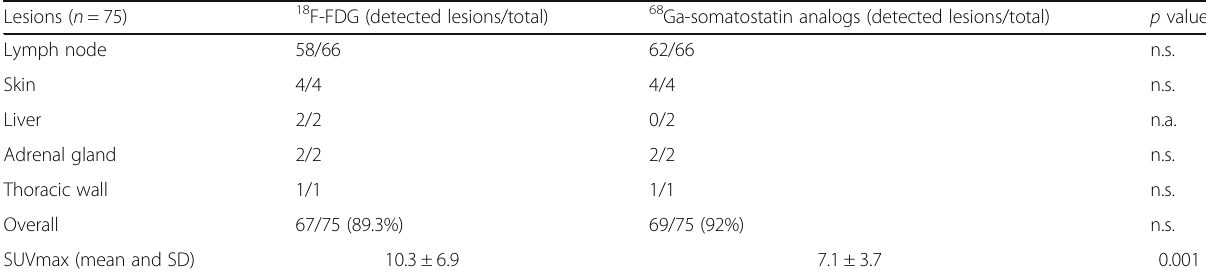
Table 3 Results of PET/CT on a lesion-based analysis Lesions ( n = 75) 18 F-FDG (detected lesions/total)